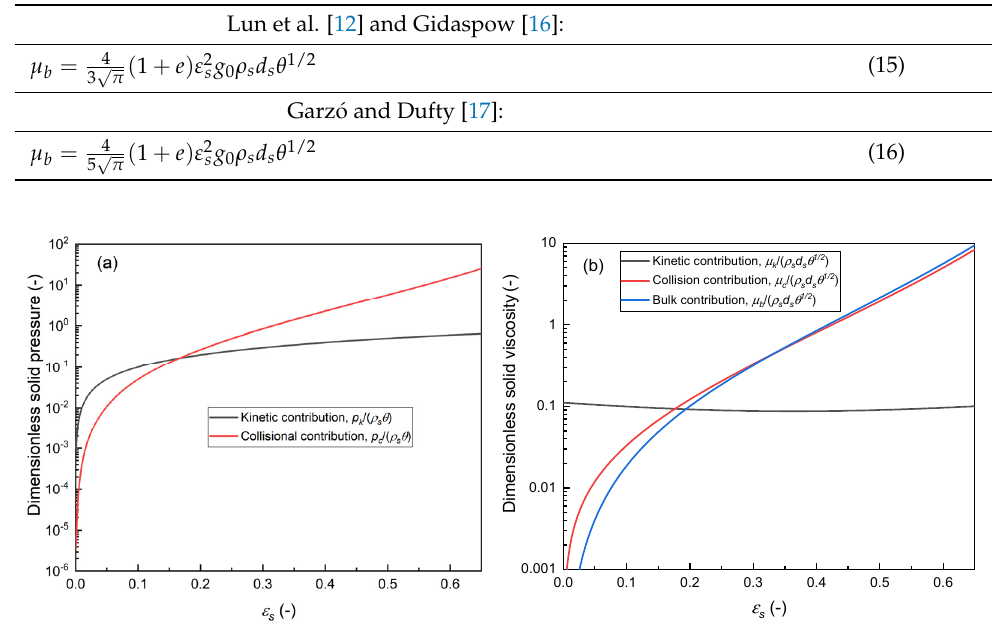
Figure 2. Dimensionless solid pressure and viscosity variation with different contributions, ( a ) Solid pressure, ( b ) Solid viscosity (This figure is plotted based on the model of Lun et al. [12]).